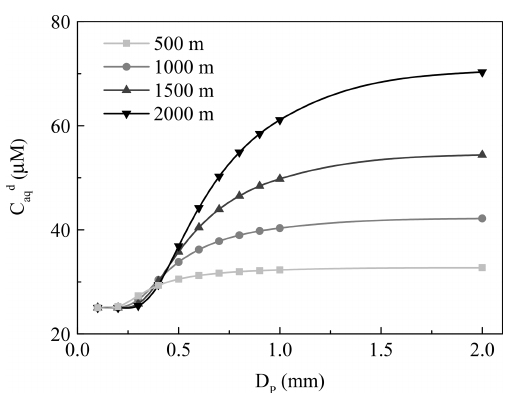
Figure 2. The dependence of the concentration of H 2 O 2 in the ground raindrops ( C d aq ) on the diameter of the raindrops ( D P ). The light grey, grey, dark grey, and black lines denote fall distances of 500, 1000, 1500, and 2000m,